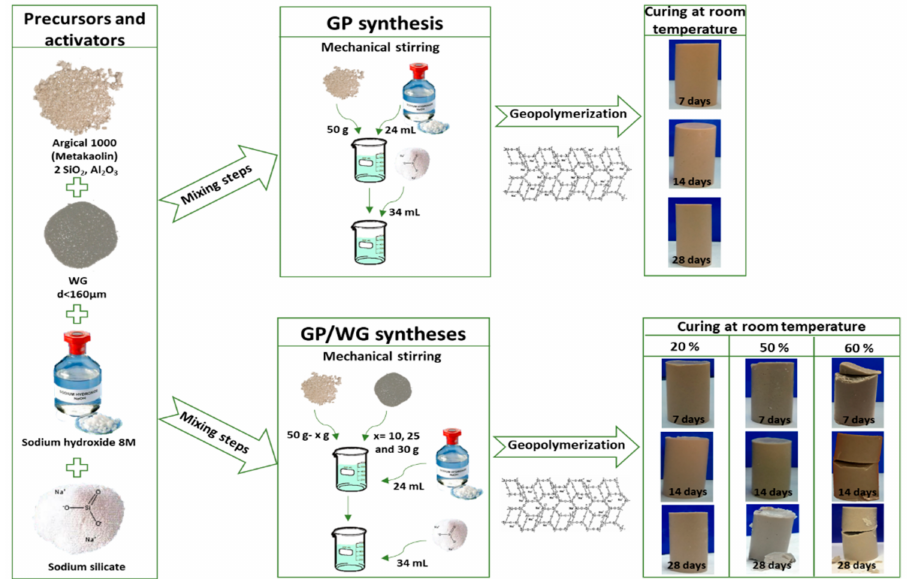
Figure 2. Flow diagram of GP and GP/WG (20, 50 and 60%) formulations and